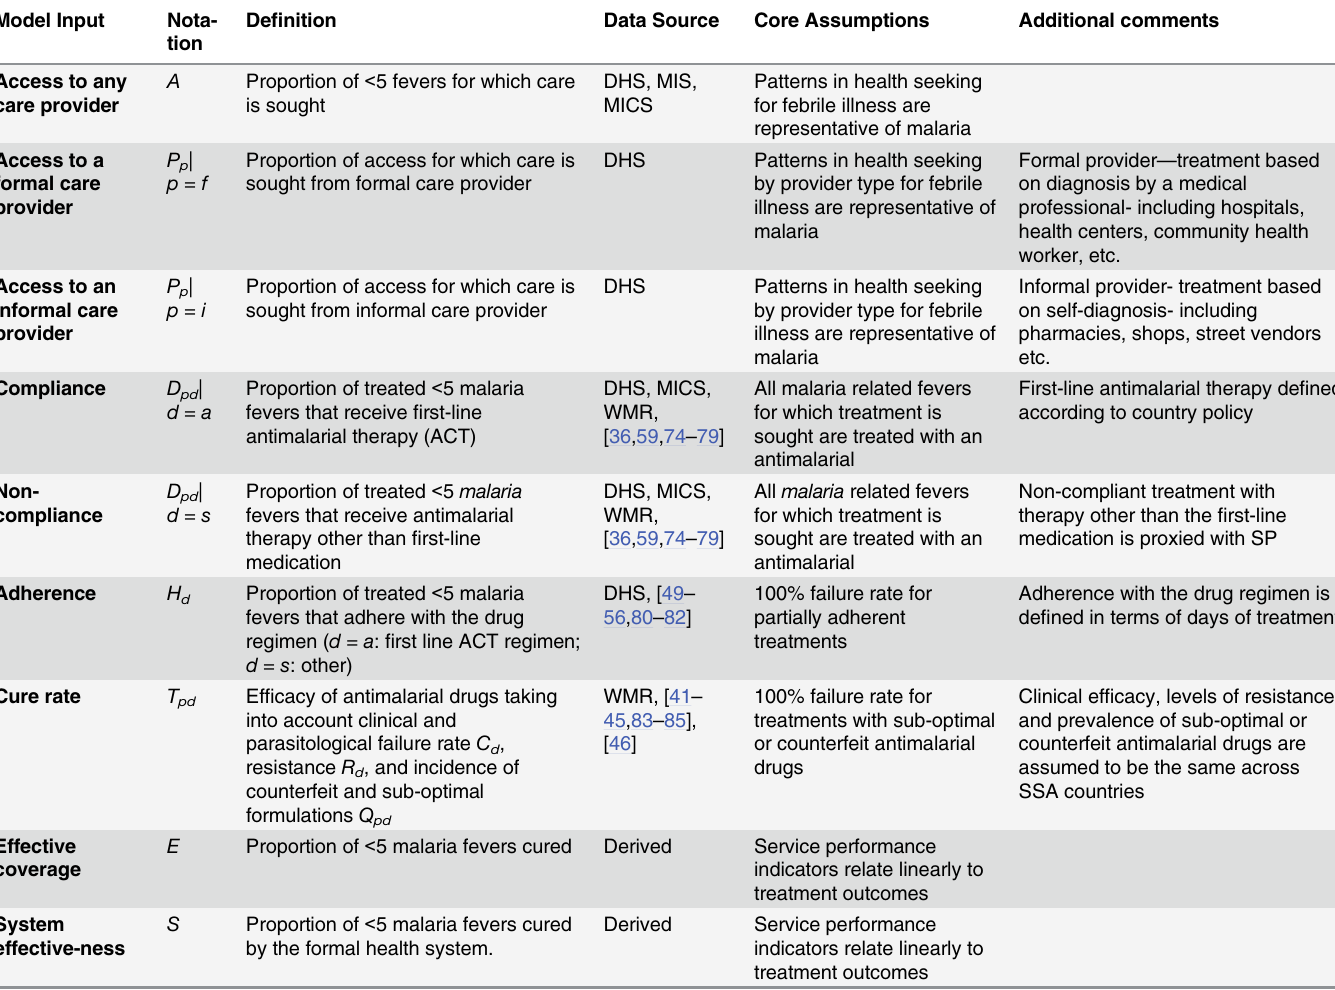
Table 1. Summary of Definitions, Sources of Data and Key Assumptions on Malaria Service Performance